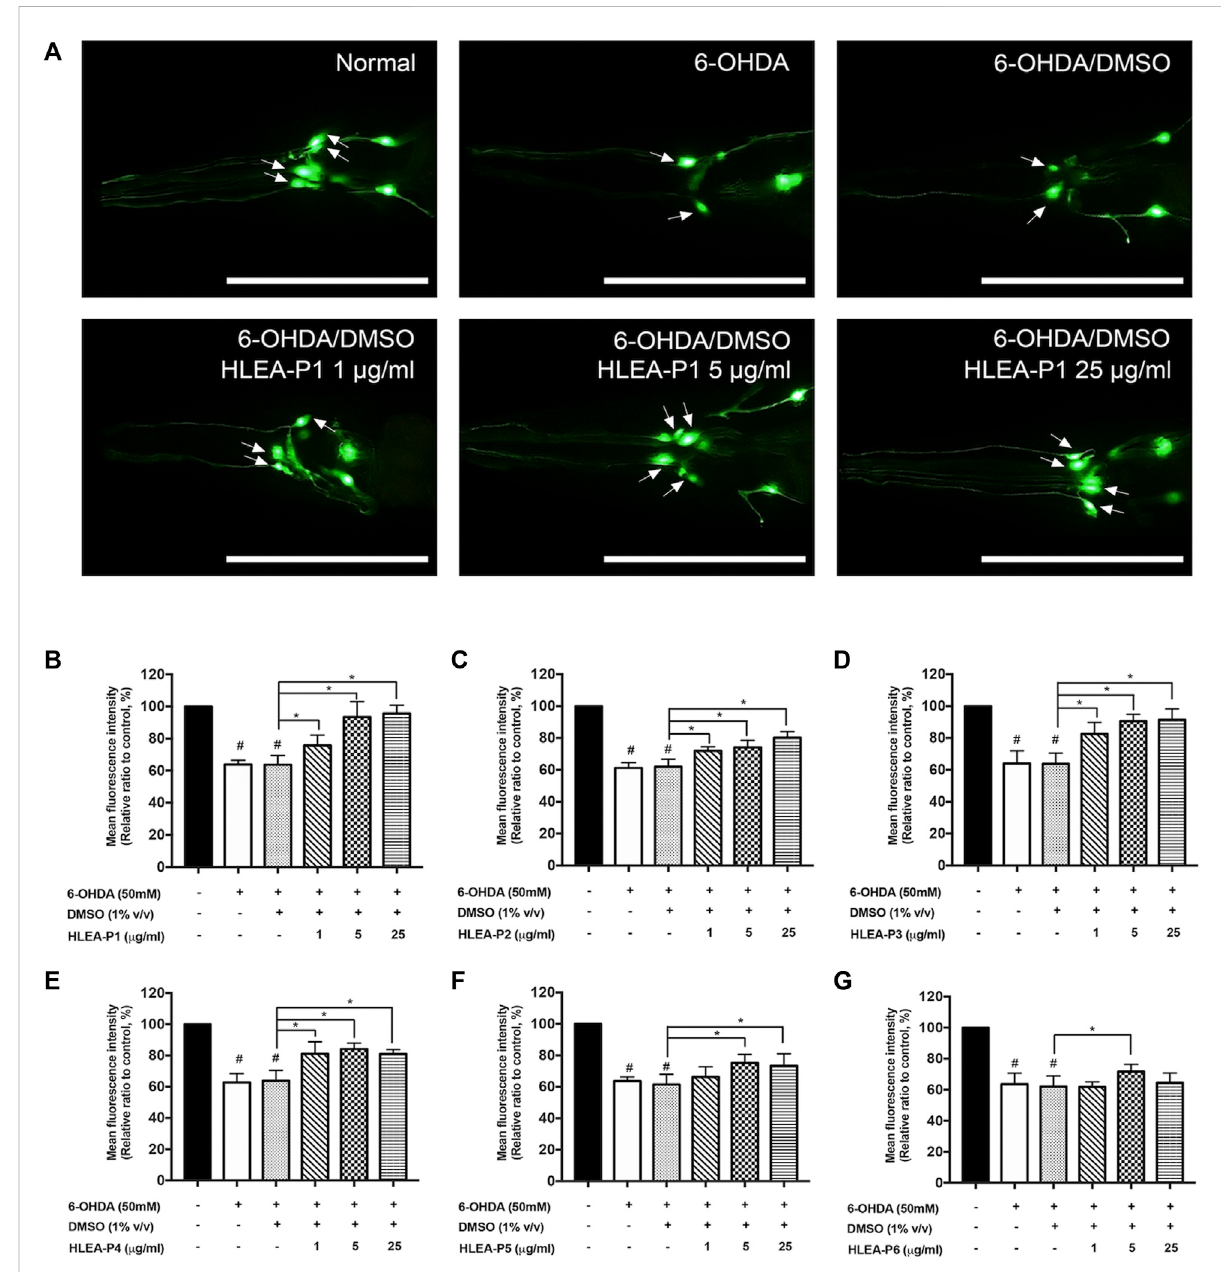
FIGURE 1 Effect of HLEA compounds 1 – 6 against 6-OHDA-induced DAergic neurodegeneration in C. elegans PD model. (A) Representative GFP expression pattern in CEP neurons (white arrows) of normal BY250, 6-OHDA-induced BY250, and 6-OHDA-induced worms with HLEA-P1 treatmentatdosesof1,5,and25 μ g/ml. (B – G) Graphicalrepresentationforrelative fl uorescentintensityofGFPexpressioninCEPneuronsofnormal BY250,BY250exposedto6-OHDA,BY250exposedto6-OHDA/DMSO,andBY250exposedto6-OHDAwithHLEAcompound1 – 6atdosesof 1, 5, and 25 μ g/ml. The data are presented as mean ± SD ( n = 30, number of animals). The hash (#) indicates asigni fi cant difference between normal and 6-OHDA-induced worms ( p < .05). The asterisk (*) indicates signi fi cant differences between untreated group (6-OHDA/DMSO) and HLEAs- treated groups at p < .05. Scale bar is 100 μ